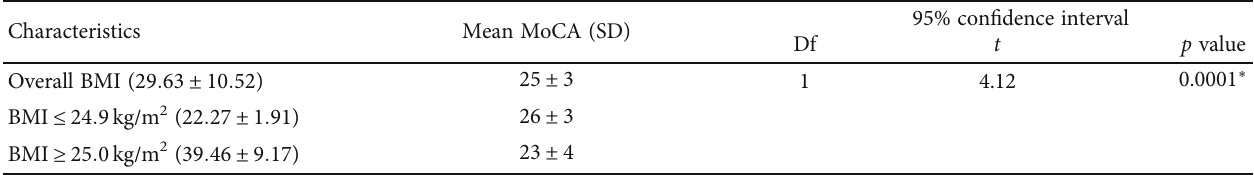
Table 2: MoCA and BMI characteristics of all the participants in the study.